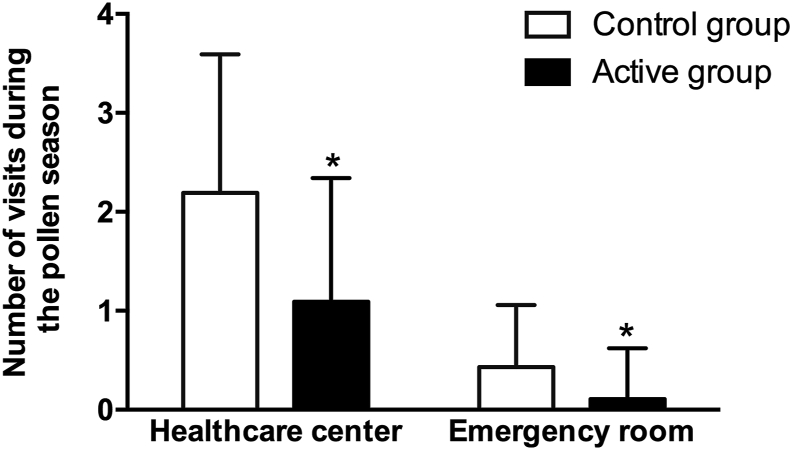
Mean number of unscheduled visits to the healthcare center (A) and to the emergency room (B) during the pollen season in patients in the control and active treatment groups. Columns and error bars represent the mean and standard deviation, respectively. ∗Student's T test, P < 0.05